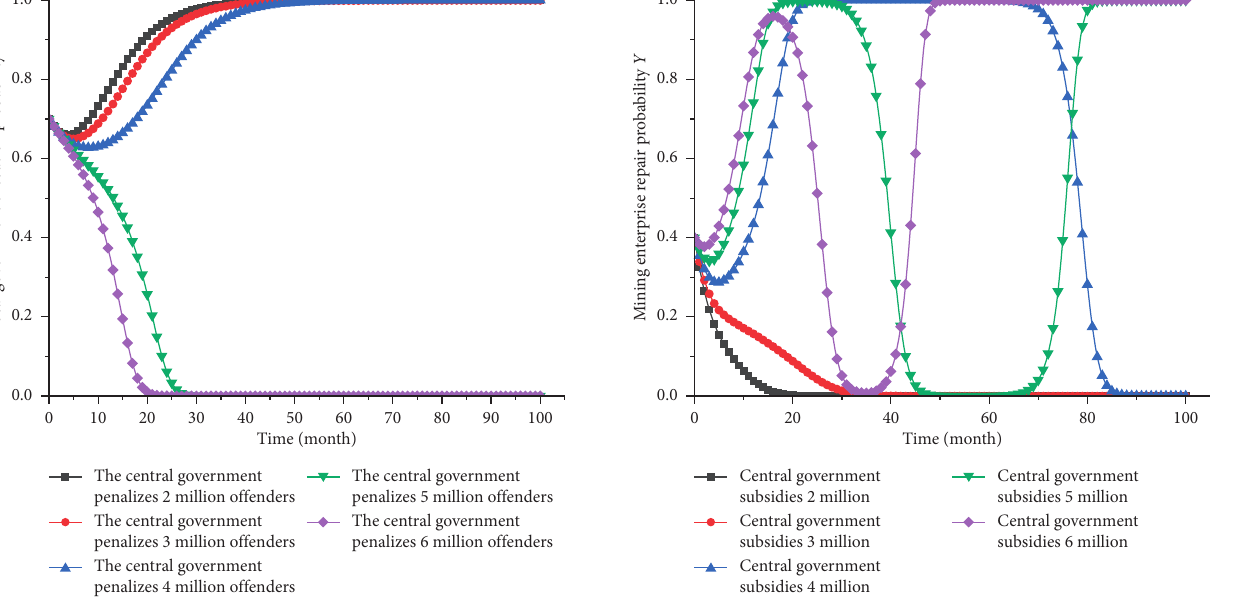
Figure 13: The impact of central subsidies on mining companies’ strategic